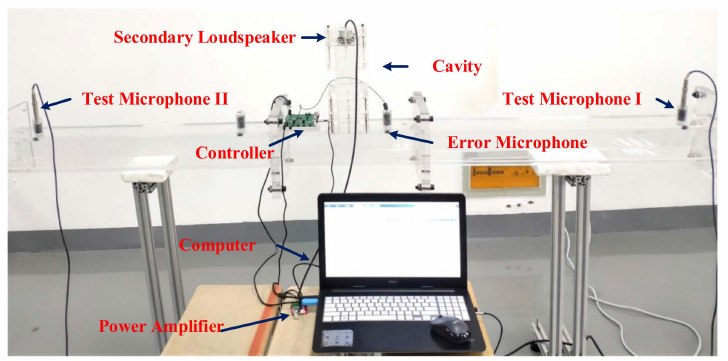
Figure 4. The experimental ANC system.